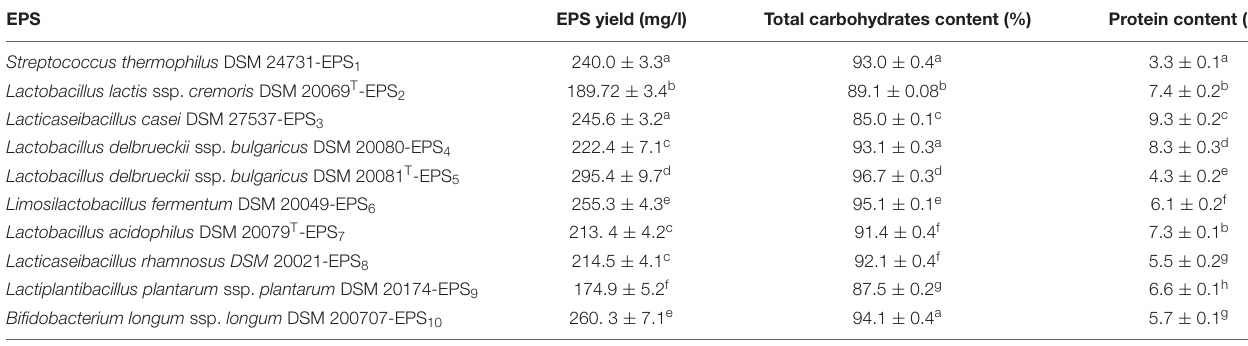
TABLE 1 | Production of crude EPS by different LAB and Bb strains.